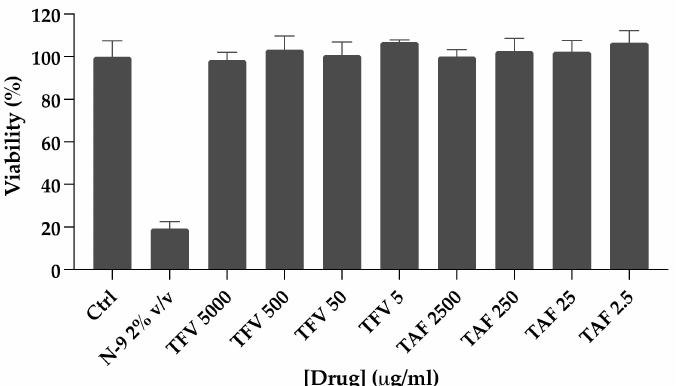
Figure 1. Viability of foreskin explants in the presence of TFV or TAF. Foreskin tissue explants were dosed ex vivo with serial dilutions of TFV or TAF for 24 h. Data are the means (SEMs) from independent experiments performed in duplicate with specimens from two